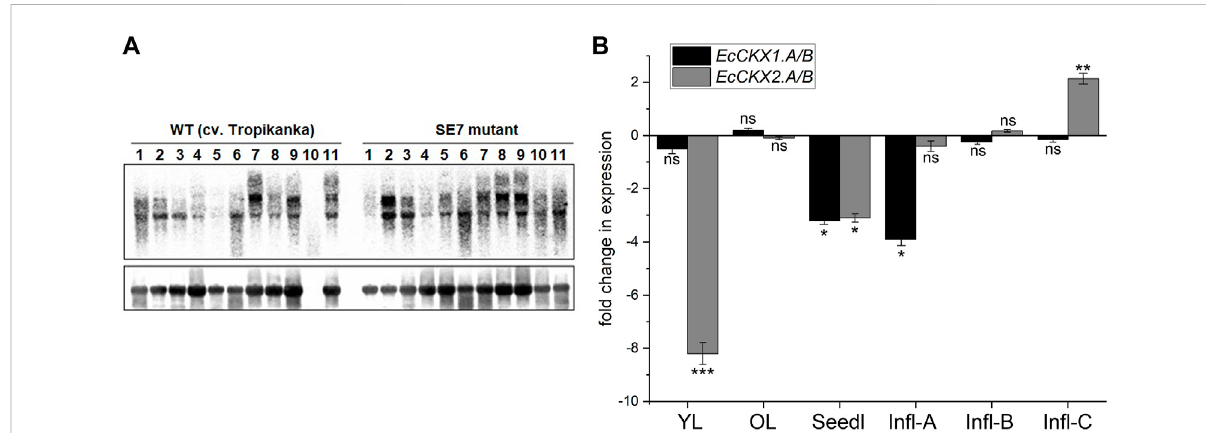
FIGURE 7 Expressionpro fi lingof EcCKX genesinthe E.coracana mutantSE7line. (A) — Northernblotofdifferenttissuesanddevelopingstagesofwildtype and mutant SE7 fi nger millet plants hybridized with the EcCKX sequence as a probe (above): 1 — node; 2 — upper leaf; 3 — lower leaf; 4 — internode; 5 — young root; 6 — seedling 4 DAI; 7 — developing panicle, < 1 cm in length; 8 — developing panicle, 2 – 3 cm; 9 — developing panicle, 3 – 4 cm; 10 — developingpanicle, > 4 cm;11 — seedling,5DAI.Thesignalswerequanti fi edbysequentialhybridizationwitharibosomalfragmentasprobe (below). (B) — Transcript pro fi ling of the EcCKX1. A / B and EcCKX2. A / B genes in the developing in fl orescences and young leaves of fi nger millet determined byquantitative RT-PCR analysis:YL — young leaf; OL — old leaf; Seedl — seedling 5 DAI; In fl -A/B/C — in fl orescence tissue at stage A, B, and C. Data shown as fold change of upregulation of downregulation of respective gene in SE7 mutant line, compared to WT: ns — difference not